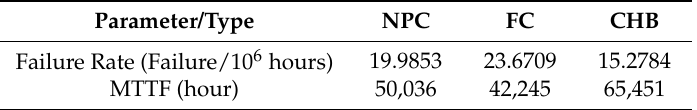
Table 7. The calculated MTTF for different multilevel inverters using the exact